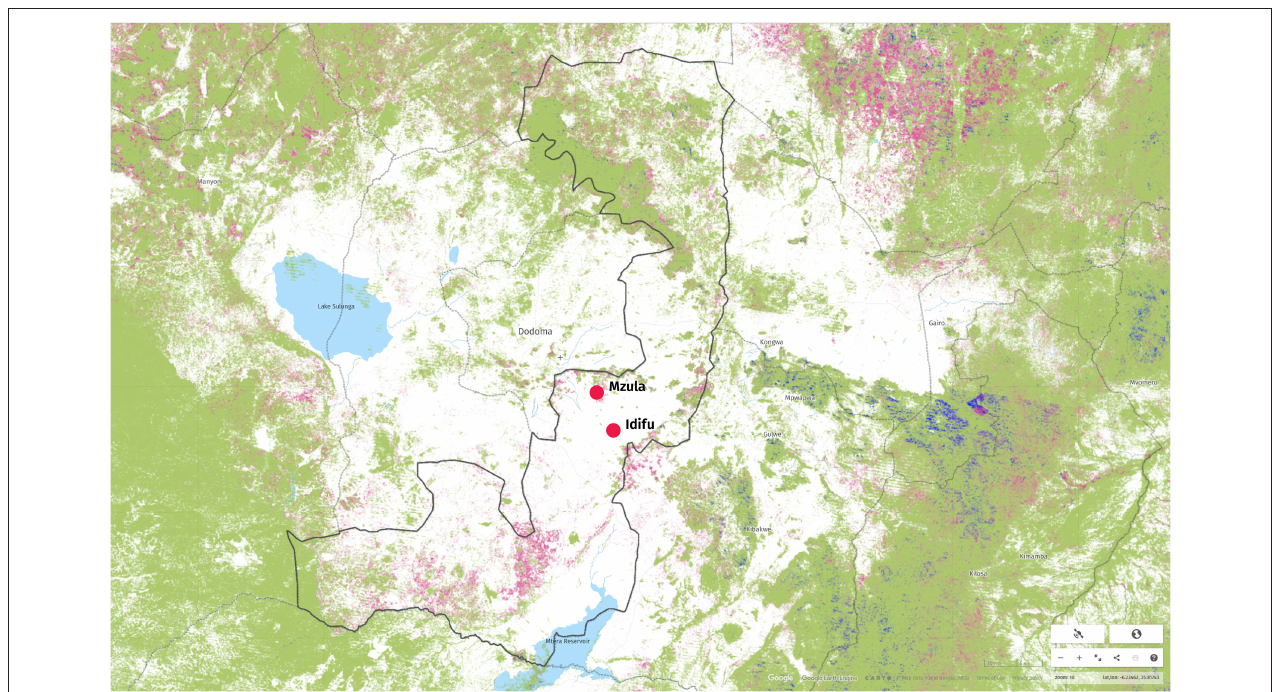
FIGURE 1 | Map of Chamwino district displaying the tree cover (green), tree cover loss (red) and tree cover gain (blue) with canopy density of 10%, including the case study villages Mzula and Idifu (World Resources Institute, 2019).